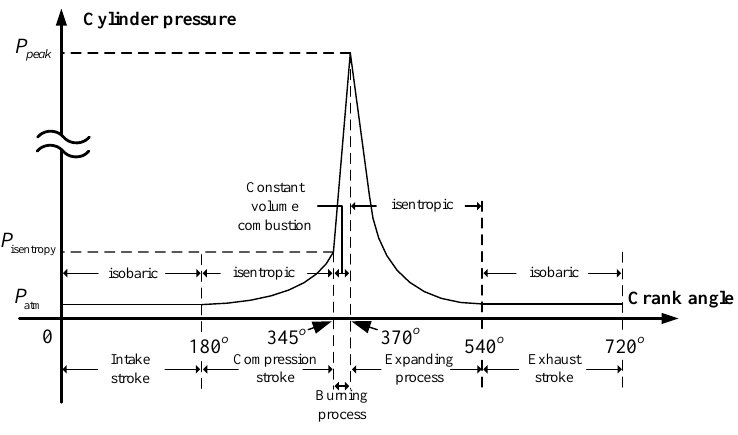
Figure 4. Diagram of the standard working cycle.